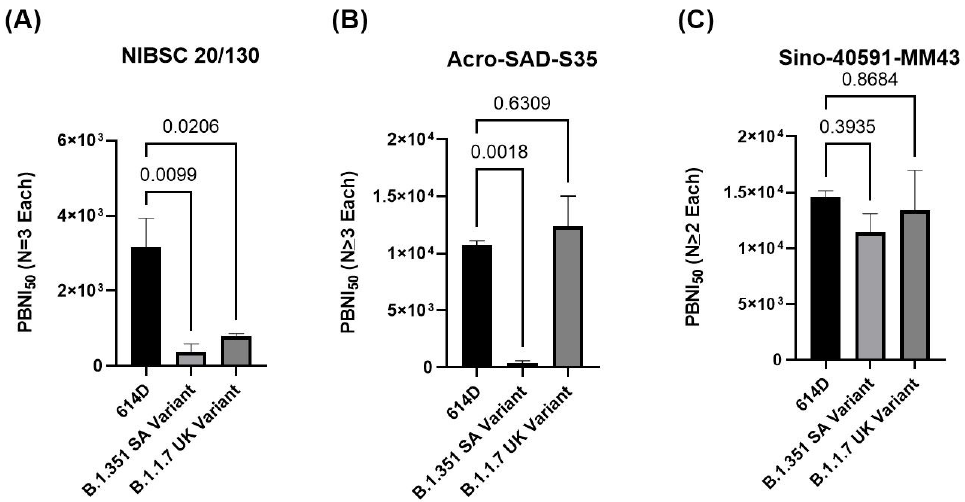
Figure 5. The NIBSC 20/130 control shows lower neutralization against VOCs compared to 614D: Three positive controls (NIBSC 20/130, Acro-SAD-S35, Sino 40591-MM43) were subjected to PBNA using the pseudoviruses for the 614D ( A ), B.1.351 SA ( B ), and B.1.1.7 UK ( C ) variants, as described in Section 2. Ave ± SD of PBNI 50 from multiple experiments as indicated in the figure are shown on the Y -axis. Ordinary one-way analysis (multiple comparisons) was performed using GraphPad Prism version 9.1.1 for Windows; GraphPad Software, San Diego, CA, USA, www.graphad.com (accessed on 15 July 2021) Adjusted p -values are shown in the figure. Table 1. PBNI 50 data from independent experiments is shown in the table. A commercially available